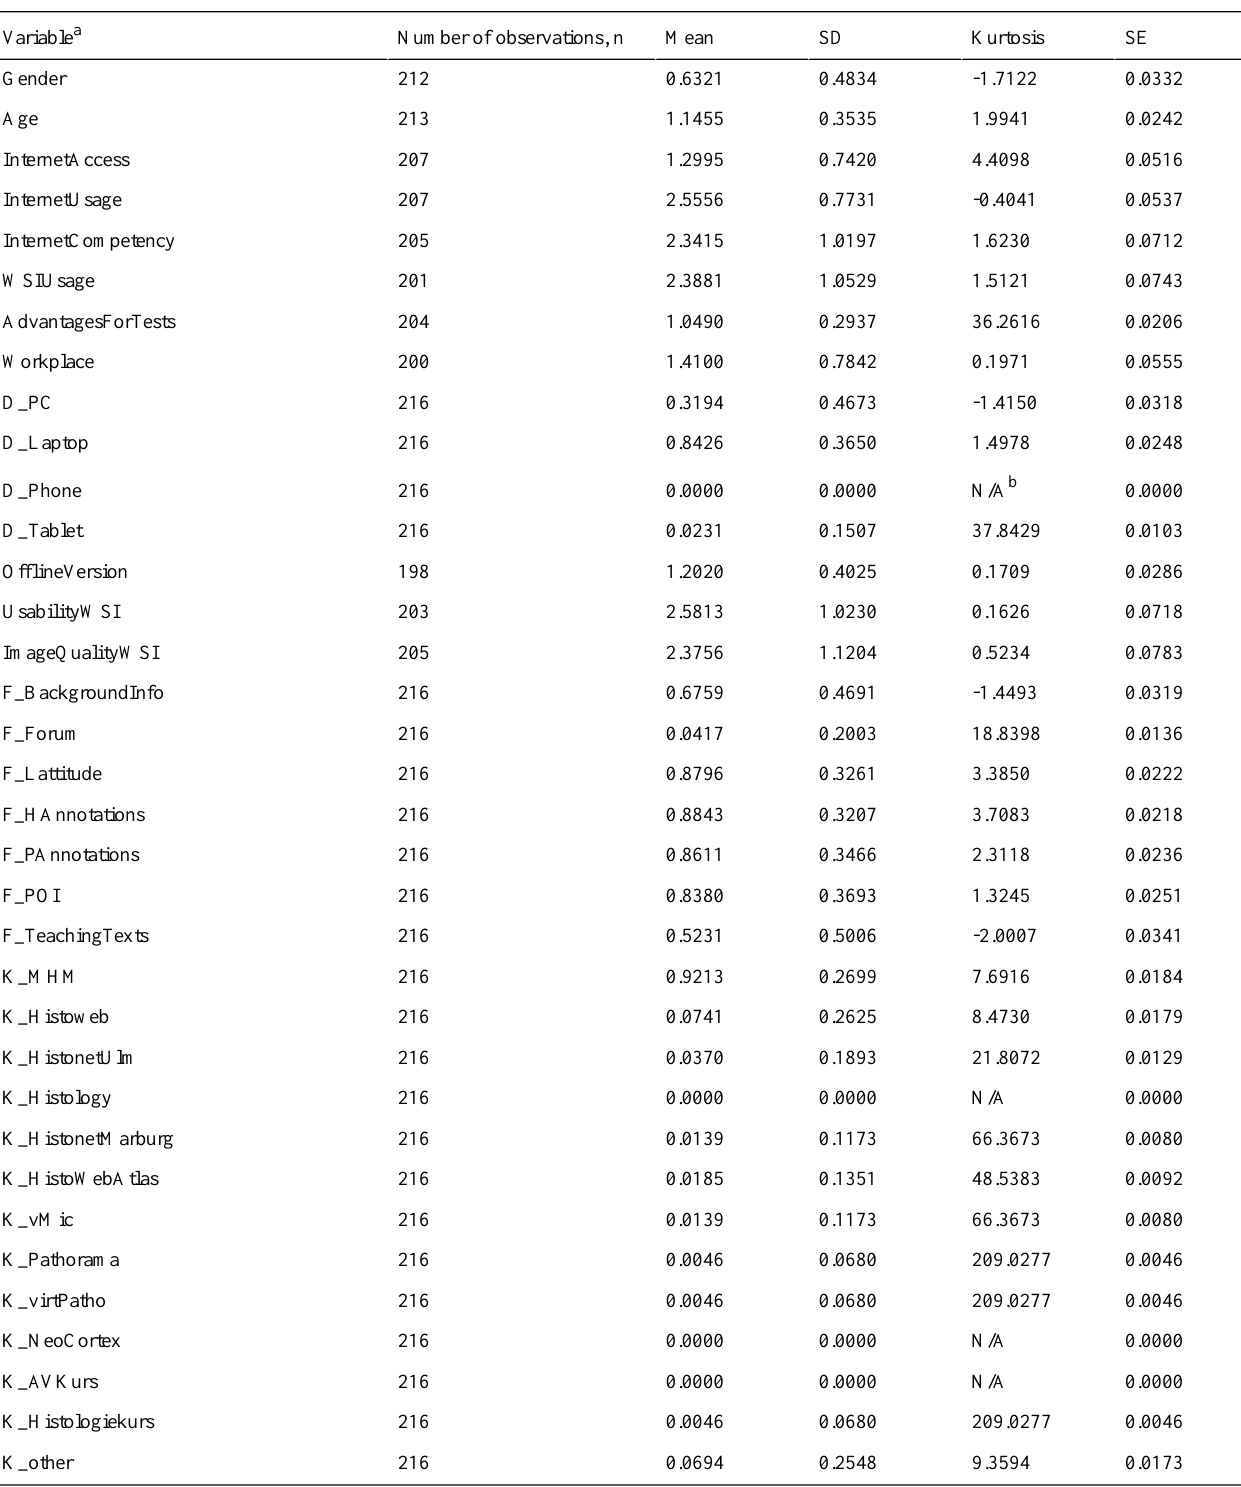
Table 1. Descriptive analysis of the dataset of the questionnaire.